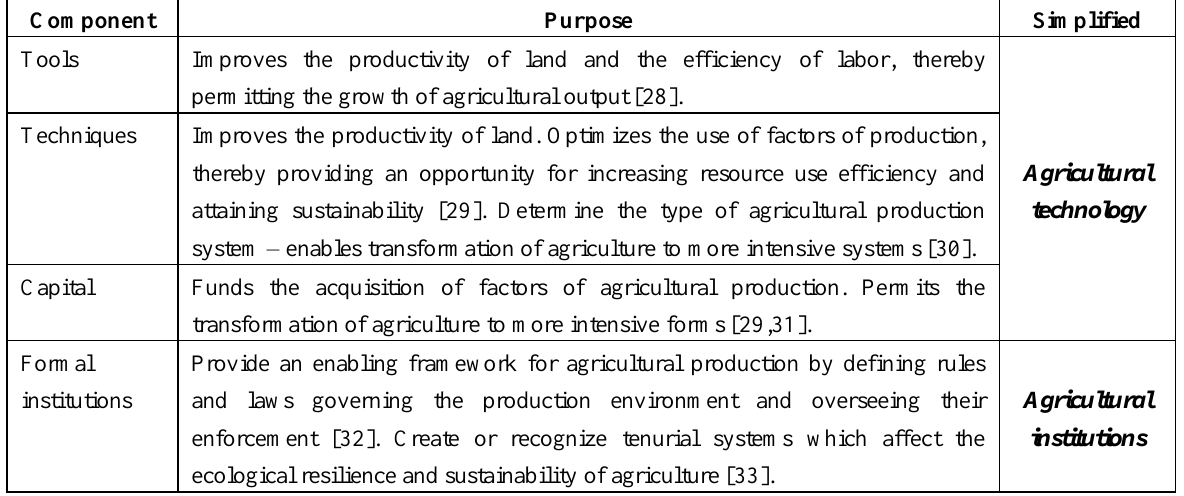
Table 1. Simplification of components of agricultural